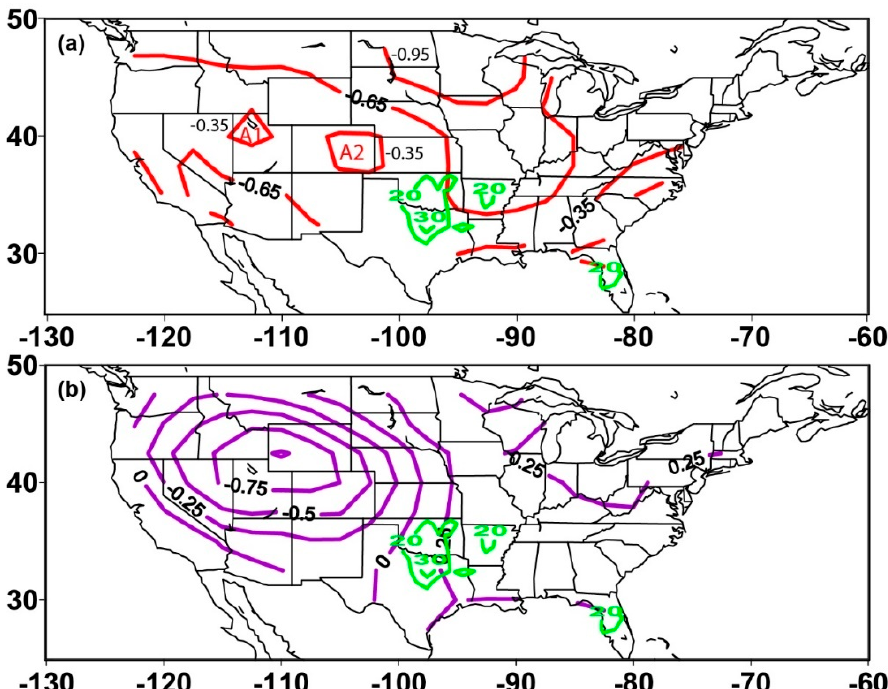
Figure 4. Composite for 10 coldest years of ( a ) surface air temperature anomaly (°C) with relative warm centers labelled by A1 and A2, and ( b ) mean sea level pressure anomaly (Pa). The (E)F1-(E)F5 tornado counts (contours) over the same period are in green colors in ( a ) and ( b ).